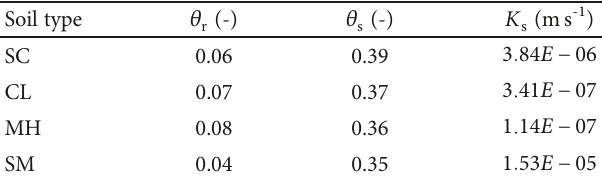
Figure 10: The triggering mechanisms hypothesized according to the experimental evidences: (a) failure induced by an uprise of a temporary perched water table (for soils with relatively low initial water content); (b) failure induced by the advance of the wetting front (for soils with relatively high initial water Table 3: Hydrodynamic parameters for the four soil types of Monte Mario ( θ r : residual water content; θ s : saturated water content; K s : hydraulic conductivity).